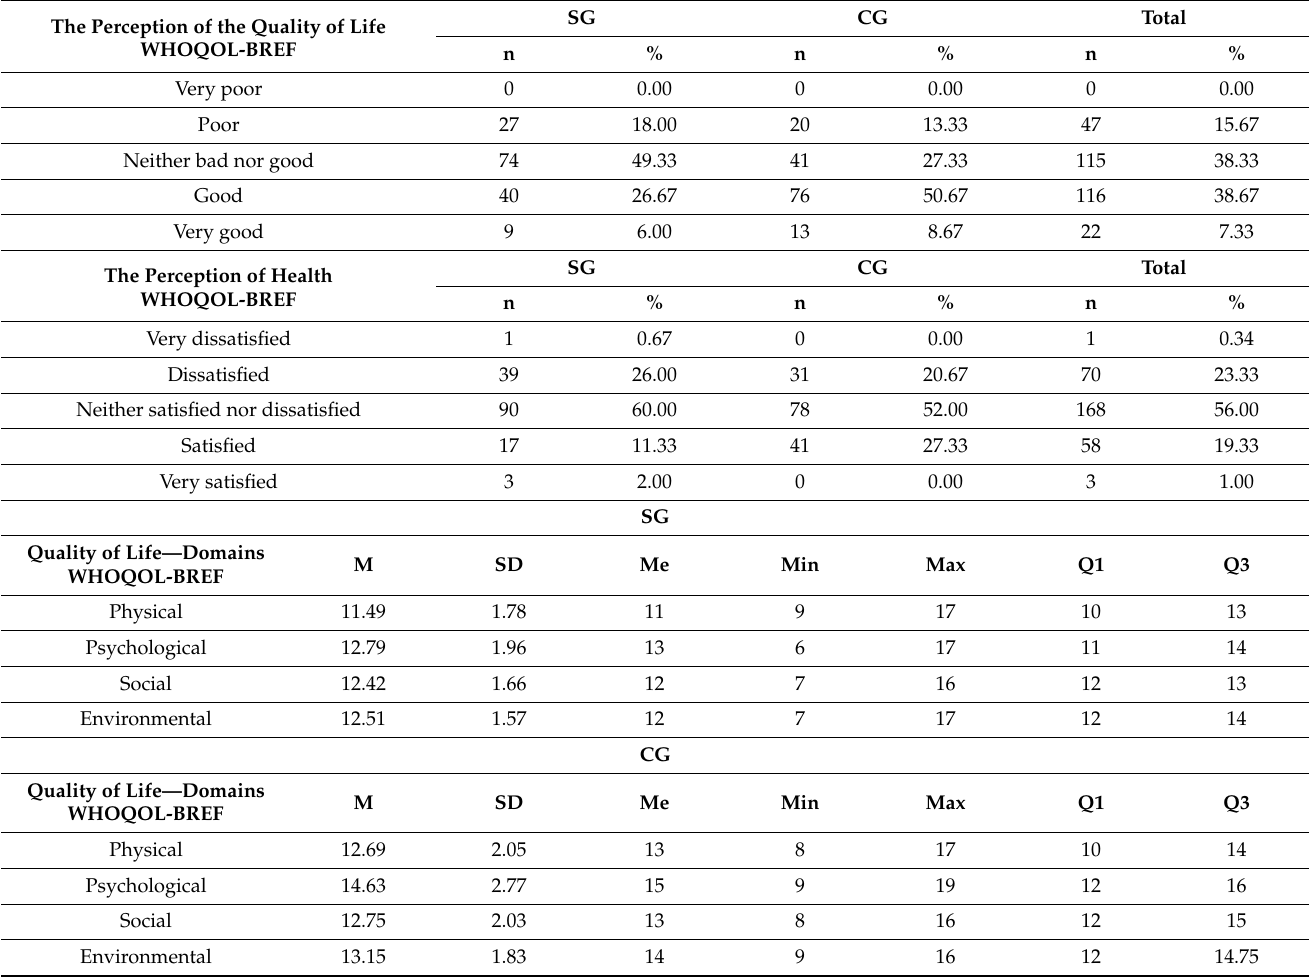
Table 6. Diversification of SG and CG in terms of quality of life outcomes.